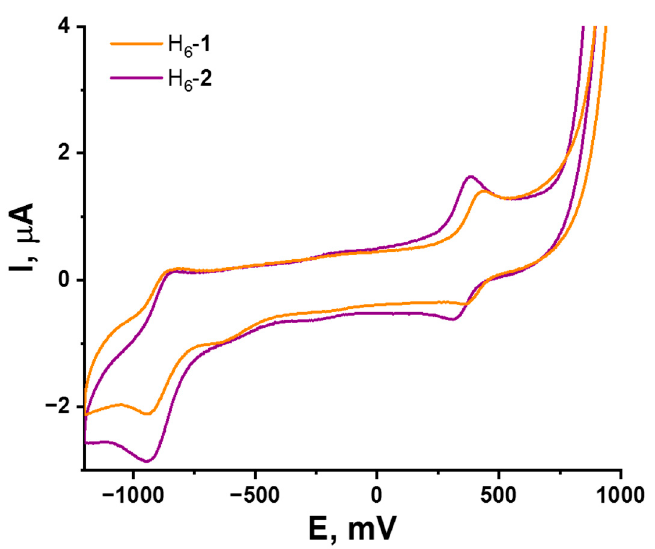
Figure 3. Cyclic voltammetry of H 6 - 1 and H 6 - 2 (0.5 mM) in 0.1 M Bu 4 NClO 4 DMSO solution; scan rate—100 mV/s. Reference electrode: Ag/AgCl/3.5 M KCl.